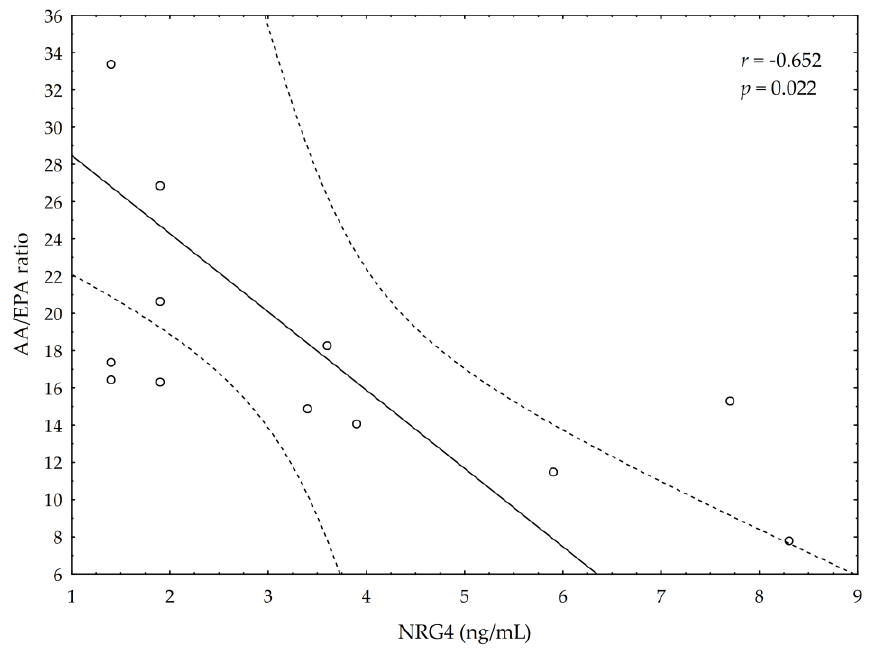
Figure 3. Correlation between AA/EPA ratio and serum neuregulin 4 (NRG4) levels.